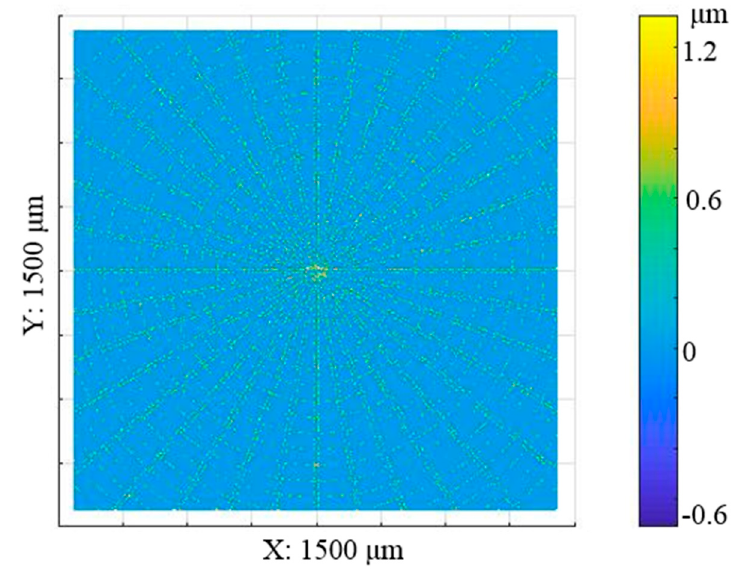
Figure 12. Error map compared with the design surface.